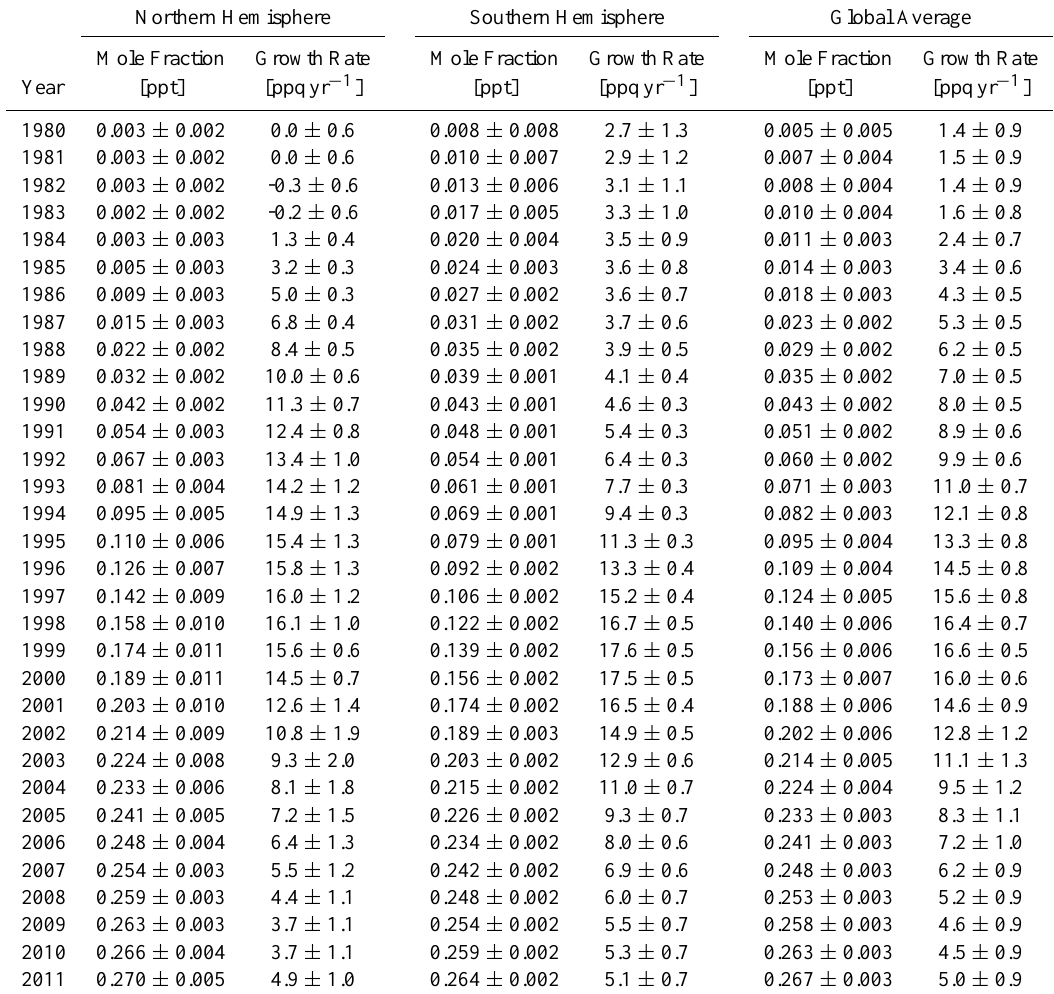
Table 5. Northern and Southern Hemisphere and Global Average Annual Mean Mole Fractions and Growth Rates and Associated Uncer- tainties 1980-2011 for C 6 F 14 .